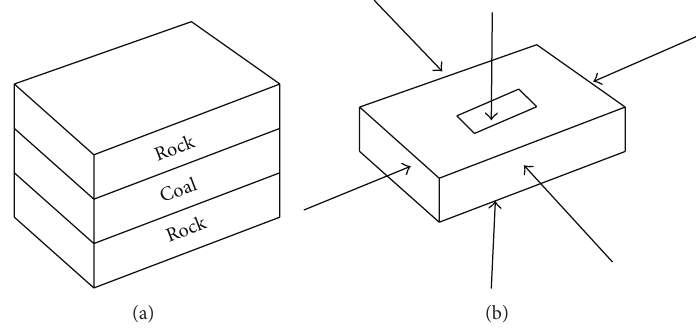
Figure 7: (a) Computational model and (b) model of a coal seam